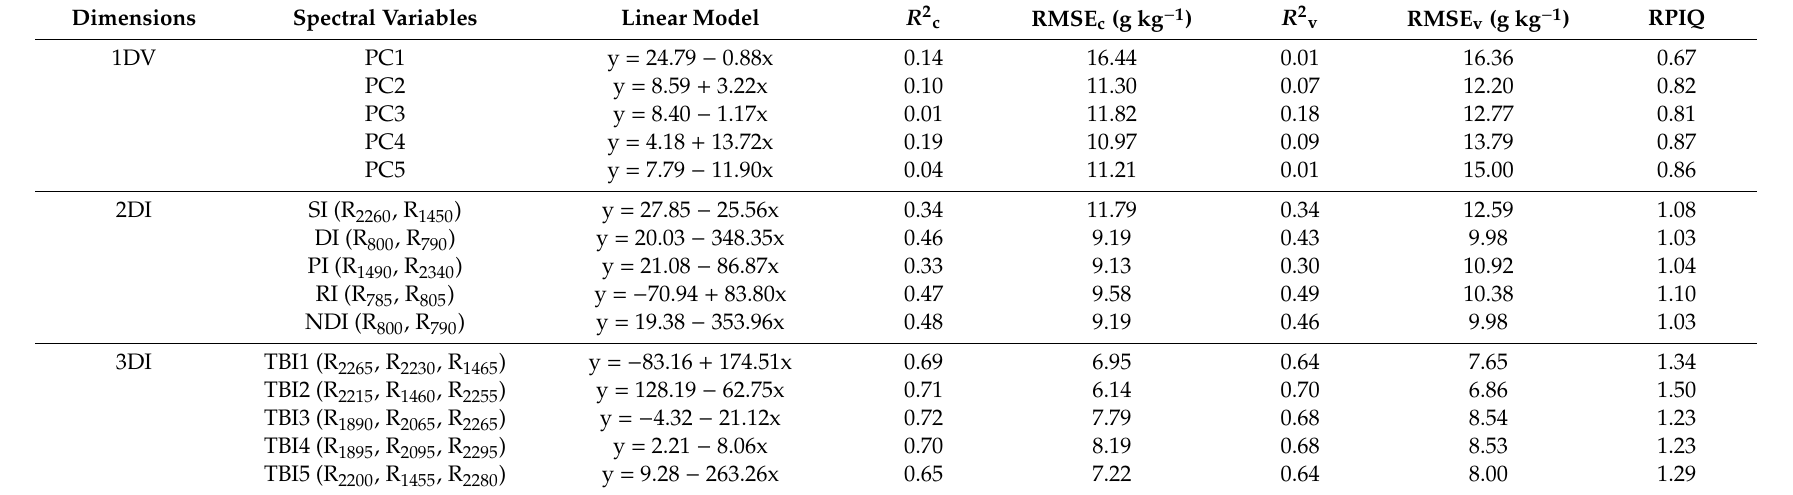
Table 3. Quantitative relationship between SOM and spectral variables of di ff erent numbers of dimensions in the calibration ( n = 112) and validation ( n = 56) datasets.